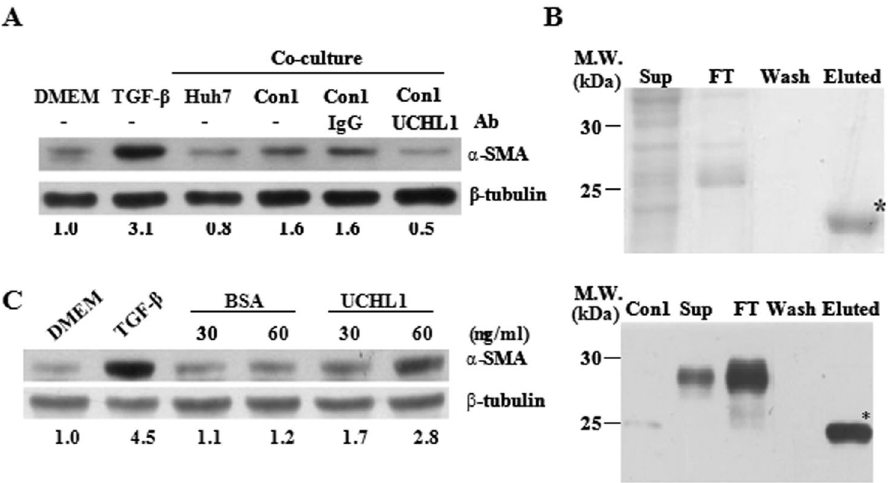
Figure 5. UCHL1 induced HSCs activation. ( A ) HSC-T6 cells (1 × 10 6 cells) were co-cultured with Con1 or Huh7 cells (1 × 10 5 cells) in the presence or absence of anti-UCHL1 antibody or mouse IgG control antibody for 24 h. The HSC-T6 cell lysate was collected and the expression of α -SMA was determined by Western blot analysis. HSC-T6 cells treated with DMEM and TGF- β 1 were used as the negative and positive control of HSC activation, respectively. The expression of β -tubulin was used as the control for equal protein loading. The number below the gel images represents the relatively α -SMA expression levels for the indicated experimental condition after normalization with the expression of β -tubulin. ( B ) Recombinant UCHL1 protein fused to the Profinity eXact tag was expressed in E . coli BL21 after IPTG induction. Samples from the indicated purification steps were fractionated on a 12% SDS-PAGE and stained with Coomassie Brilliant Blue (upper panel). The protein with an expected molecular weight of UCHL1 (21 kDa) was noted in the eluted fraction after protease cleavage of the Profinity eXact tag and was indicated as * . The recombinant UCHL1 protein in the indicated steps of protein purification was further confirmed by Western blotting using the anti-UCHL1 antibody (lower panel). The cell lysate of Con1 was used as a positive control. ( C ) HSC-T6 cells were culture in DMEM w/o FBS for 24 h and then treated with the indicated concentrations of purified rUCHL1 or BSA for an additional 24 h. The cell lysates were collected and the expression of α -SMA was determined by Western blot analysis. The expression of β -tubulin was used as the control for equal protein loading. The number below the gel images represents the relatively α -SMA expression levels for the indicated experimental condition after normalization with the expression of β -tubulin. HSCs treated with DMEM and TGF β 1 (10 ng/ml) were used as negative and positive controls for HSC stimulation, respectively. The full Western blot and the corresponding positions of the molecular weight protein markers are presented in Supplementary Fig.